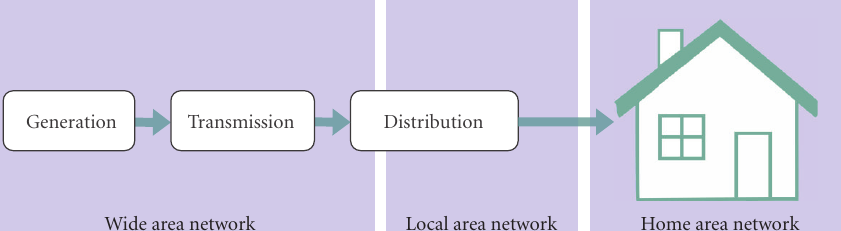
Figure 3: Smart Grid network hierarchy.